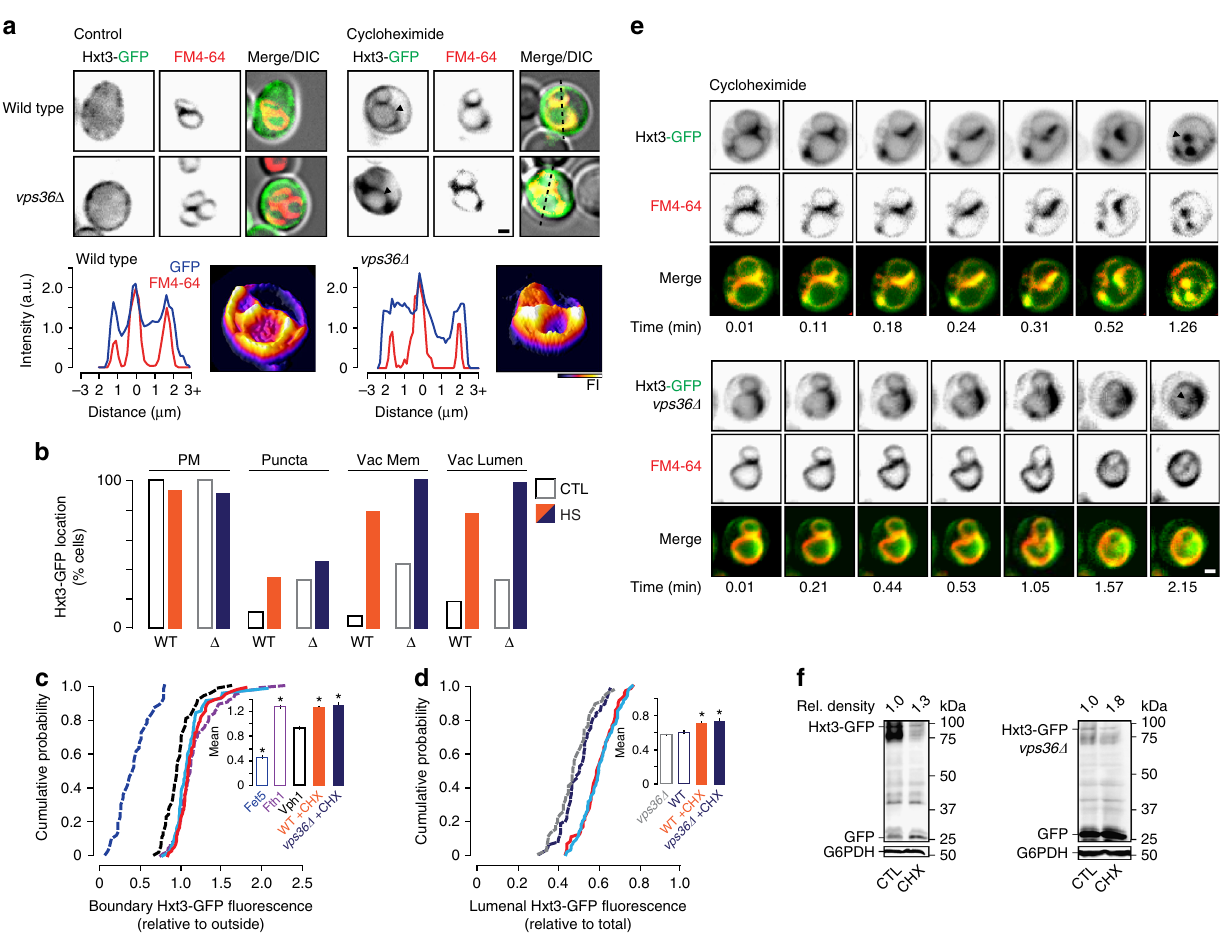
Fig. 4 Cycloheximide triggers Hxt3-GFP degradation by the ILF pathway. a Fluorescence and DIC micrographs of live wild-type or vps36 Δ cells expressing GFP-tagged Hxt3 before (control) and after treatment with 100 µ M cycloheximide for 45 min. Vacuole membranes were stained with FM4 – 64. Arrowheads indicate GFP on the vacuole membrane. Three-dimensional GFP fl uorescence intensity (FI) plots and line plots of Hxt3-GFP or FM4 – 64 fl uorescence intensity for lines shown in a , to indicate vacuole membrane localization after cycloheximide treatment. b Micrographic data shown in a was used to calculate the proportion of wild type ( n = 142) or vps36 Δ ( n = 158) cells that show Hxt3-GFP fl uorescence on the plasma membrane (PM), intracellular puncta, vacuole membrane (Vac Mem) or vacuole lumen (Vac Lumen) after treatment with cycloheximide. Values before cycloheximide treatment are shown for reference (see Fig. 3b). c , d Micrographic data shown in a was used to generate cumulative probability plots of Hxt3-GFP fl uorescence measured within the boundary membrane ( c ) or lumen ( d ) of vacuoles within live wild-type or vps36 Δ cells after treatment with cycloheximide (CHX). GFP-tagged Fet5 (excluded), Vph1 (ubiquitous), and Fth1 (enriched; see Fig. 2d) and lumenal values before cycloheximide treatment (see Fig. 3d) are shown for reference. Averages ± S.E.M. are shown in insets. * P < 0.05, as compared to Vph1 by t -test. n = 5 experiments whereby a total of 73 wild type cells or 108 vps36 Δ cells after CHX treatment were analyzed. e Images from time-lapse videos showing homotypic vacuole fusion events within live wild type or vps36 Δ cell expressing Hxt3-GFP treated with cycloheximide. Vacuole membranes were stained with FM4 – 64. Arrowheads indicate initial fusion sites leading to ILF formation. See Supplementary Movies 3 and 5. Examples shown are representatives of n = 4 experiments. f Western blot analysis of whole-cell lysates prepared from wild type or vps36 Δ cells expressing Hxt3-GFP before (CTL) or after treatment with cycloheximide (CHX) stained with anti-GFP antibody. Estimated molecular weights and cleaved GFP band densities relative to CTL normalized to load controls (G6PDH) are shown. Blots shown are representatives of n = 4 experiments. Scale bars, 1 µ